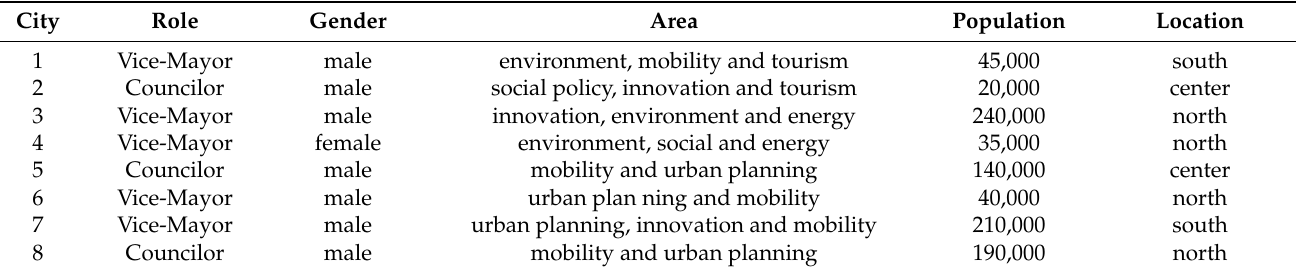
Table 1. Policymakers and cities sample